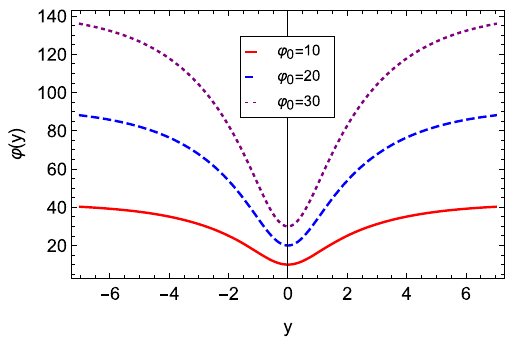
Fig. 3 Numericalsolutionsforthescalarfield ϕ ( y ) fromSect.3.3with ψ = 1 and V = 1. The scalar field satisfies the boundary condition 0 0 ϕ ( 0 ) = ϕ 0 and approaches an asymptotically constant value for 1, as